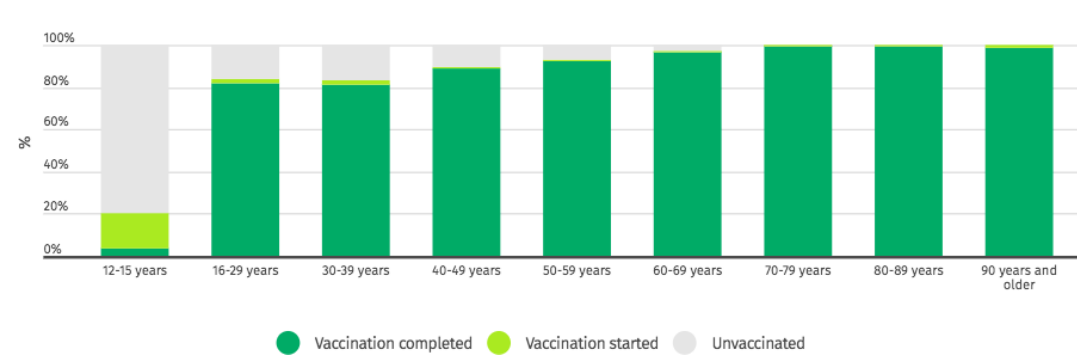
Figure 2. Percentage of vaccinated individuals in Iceland by age in August 2021